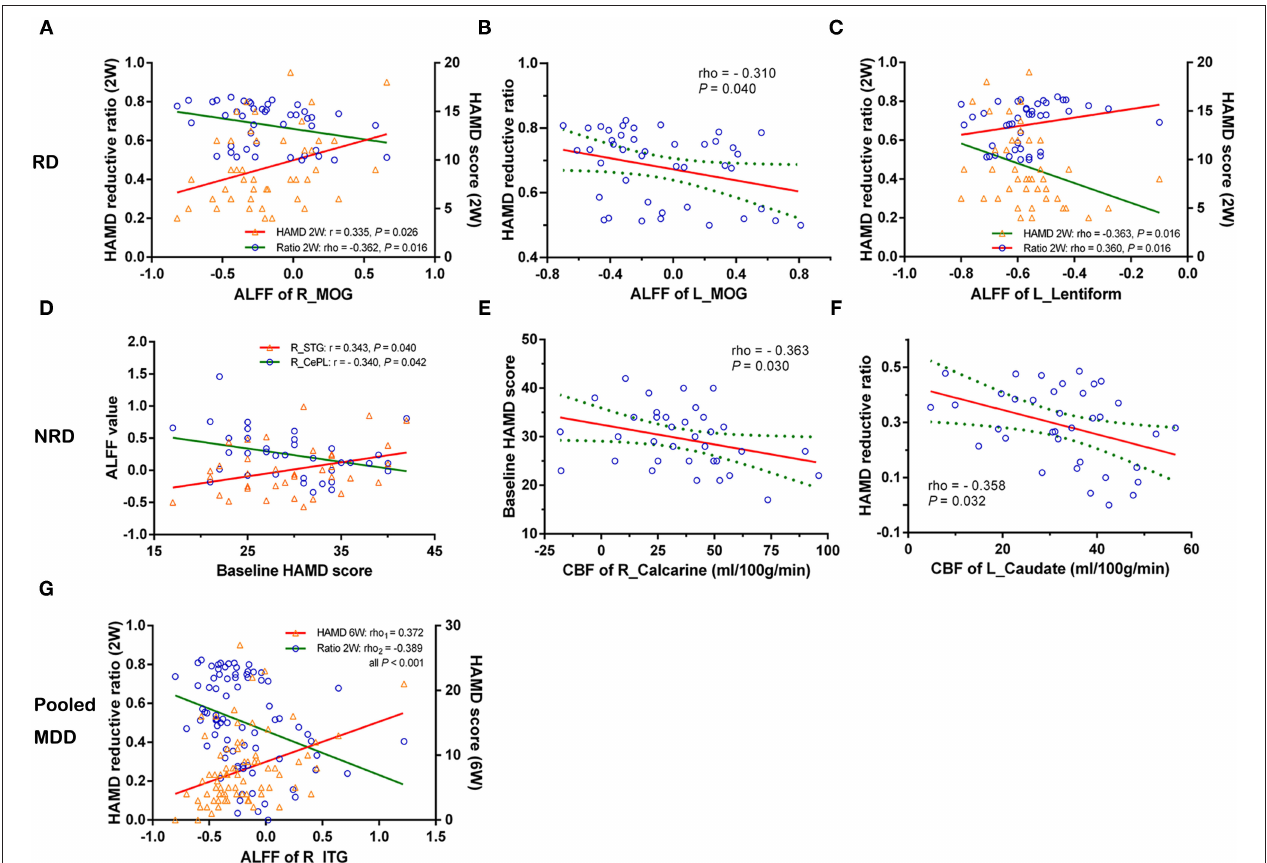
FIGURE 2 | The correlations of changed CBF and ALFF and the severity/early improvement of depression in the RD, NRD, and pooled depression groups. Row RD: (A) decreased ALFF of the R_MOG was negatively related to the reduction of the HAMD score and positively correlated with the HAMD score (2W); (B) reduced ALFF of the L_MOG was negatively related to the reduction of the HAMD score; (C) increased ALFF of the L_lentiform nucleus was negatively related to the HAMD (2W) but positively correlated with the reduction of the HAMD score. Row NRD: (D) and (E) the baseline HAMD score was positively related to higher ALFF of the R_STG but negatively correlated with lower ALFF of the R_CePL and CBF of the R_calcarine gyrus, respectively. (F) The negative correlations between higher CBF of the L_caudate nucleus and the reduction of the HAMD score. Specifically, (G) represents that the ALFF of the R_ inferior temporal gyrus (R_ITG) was positively related to the HAMD (6W) but negatively correlated to the reduction of the HAMD score in the pooled MDD group (RD and NRD). CBF, cerebral blood flow; ALFF, amplitude of low-frequency fluctuation; L, left; R, right; RD, responsive depression; NRD, non-responsive depression; MDD, major depressive disorder; HAMD (2W/6W), Hamilton Depression Rating Scale score at week 2 or week 6; r/rho, Pearson’s/Spearman’s coefficient; MOG, middle occipital gyrus; STG, superior temporal gyrus; CePL, cerebellum posterior lobe; ITG, inferior temporal